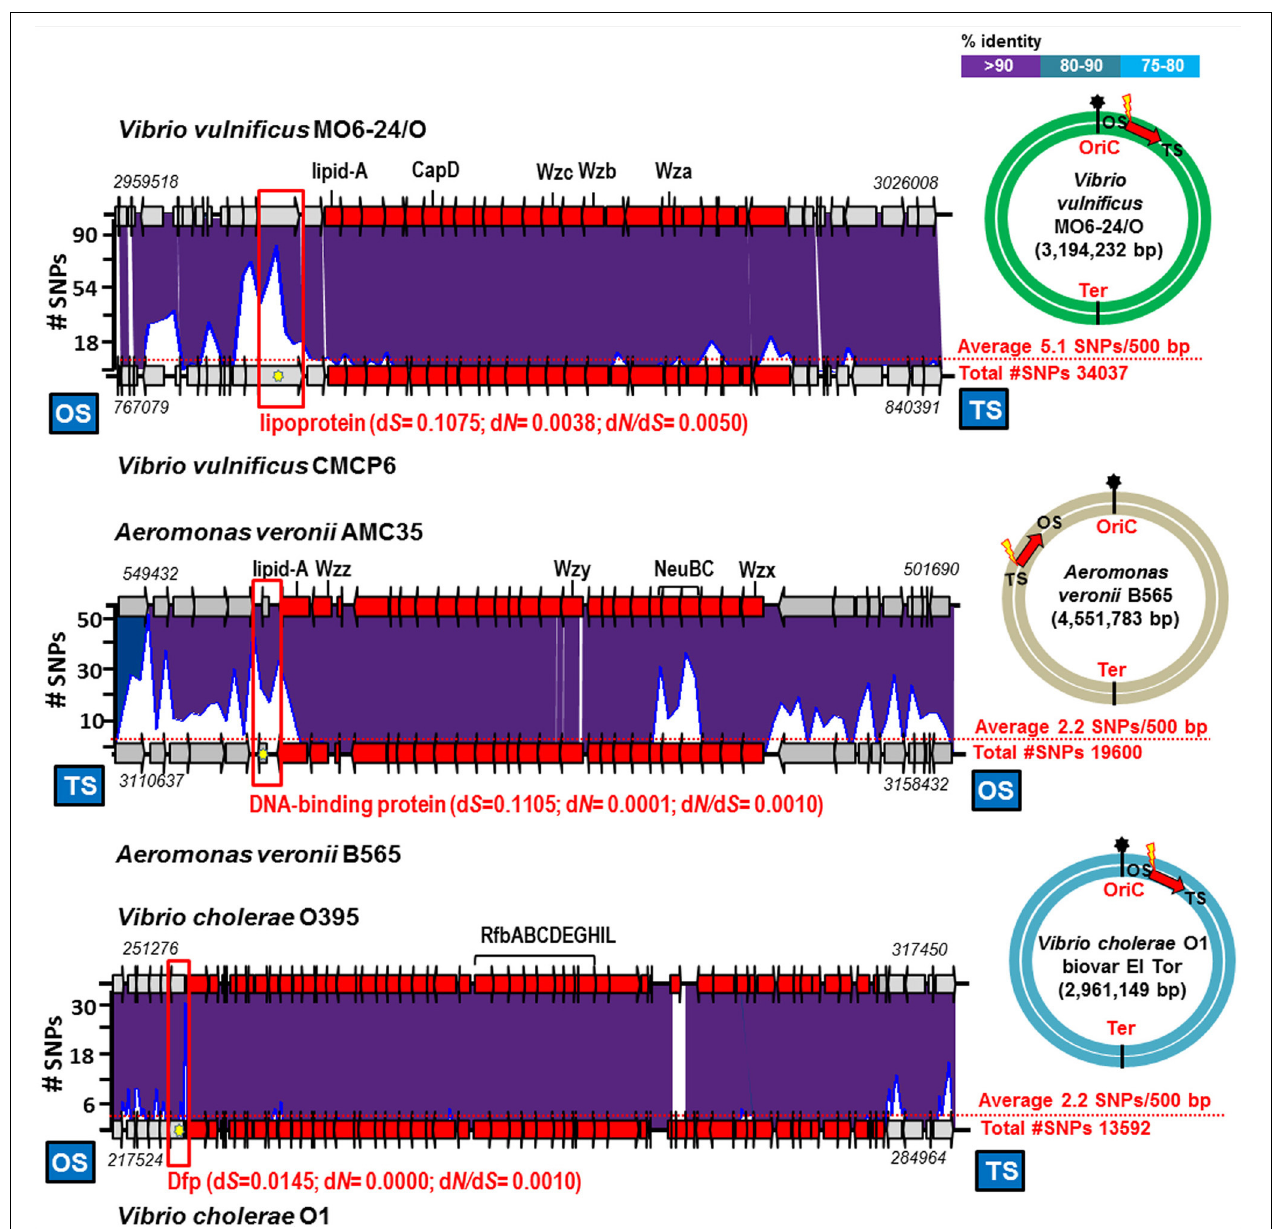
FIGURE 2 | Identical gene cluster involved in the biosynthesis of the O-chain in aquatic/pathogenic bacteria. The plots above the lower genome indicate the number of SNPs in a 500bp window. The average number of SNPs in the genome is indicated by a red dot line. Yellow star indicates position of the gene which has the